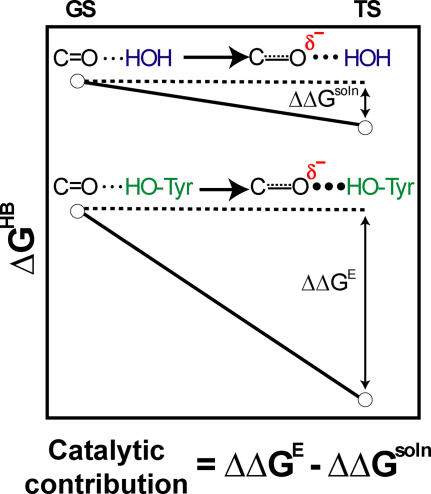
Potential Catalytic Contribution from a Greater Strengthening of Hydrogen Bonds Accompanying Charge Redistribution in an Enzymatic Environment than in Aqueous SolutionAs charge increases on the carbonyl oxygen going from the ground state to the transition state, hydrogen bonds from either water or an enzyme tyrosine will strengthen. Results from small molecule studies indicate that in a nonaqueous environment such as an enzyme active site, this strengthening (ΔΔG
E) can be greater than in aqueous solution (ΔΔG
soln), where little strengthening is observed [
68,
151,
152]. This potential differential strengthening is indicated by the different sizes of hydrogen-bonded dots and the larger change in ΔG between the ground state and the transition state for the enzymatic reaction compared with the solution reaction. Adapted from [
68].